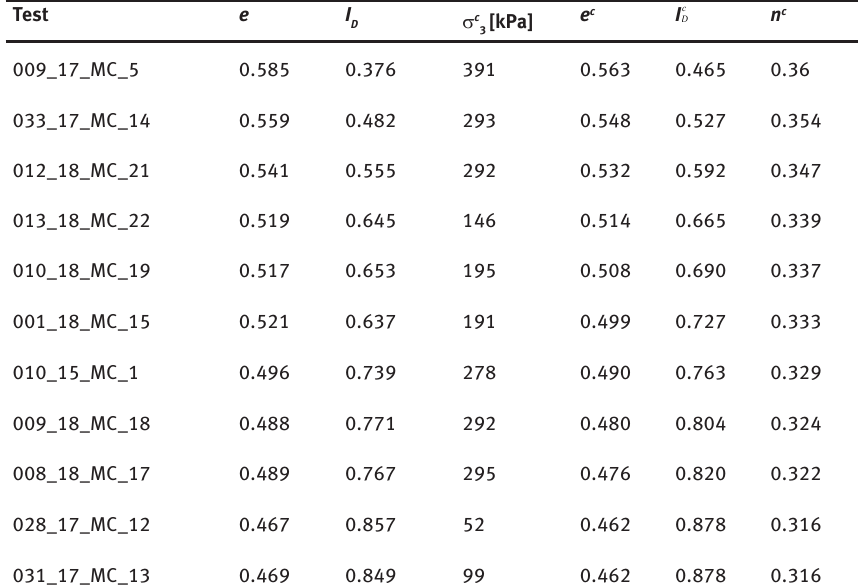
Table 2: Initial test conditions. Test